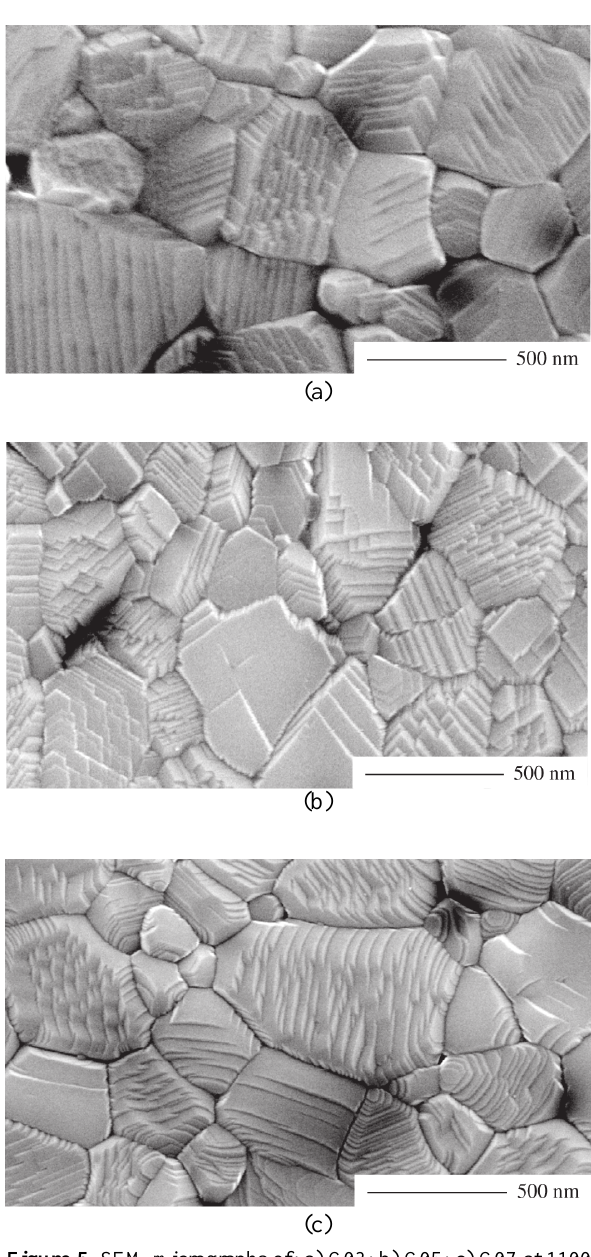
Figure 5. SEM micrographs of: a) C03; b) C05; c) C07 at 1100 °C, with a CHR of 5